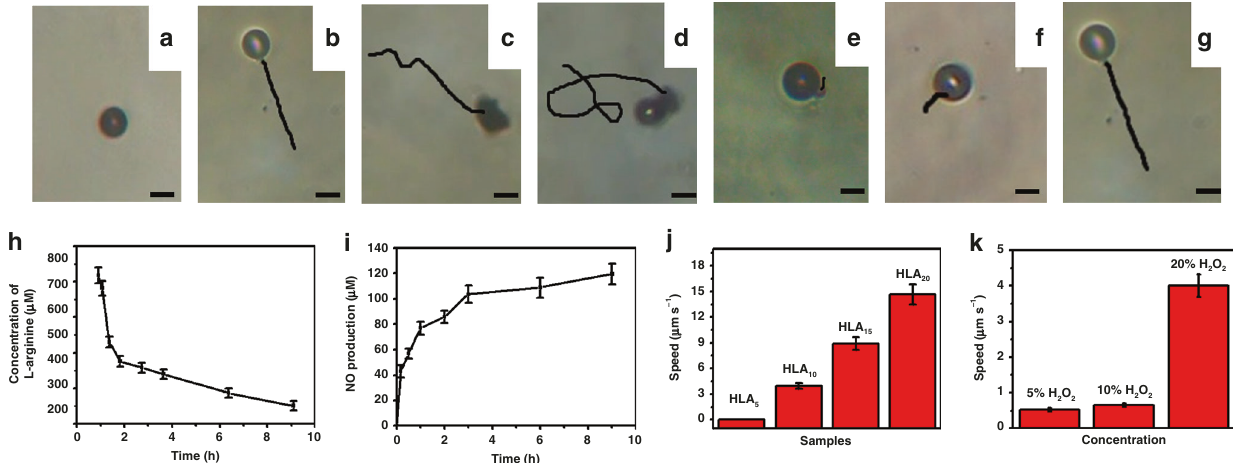
Fig. 3 Movement behavior of the nanomotors. Time-lapse images (Supplementary Movie 2) displaying the tracking trajectories of a HLA 5 , b HLA 10 , c HLA 15 , and d HLA 20 nanomotor in 10 s (20% H 2 O 2 , scale bar: 5 μ m); Time-lapse images (Supplementary Movie 3) displaying the tracking trajectories of HLA 10 nanomotor in 10 s under e 5%, f 10%, and g 20% of H 2 O 2 (Scale bar: 5 μ m); h The consumption of L -arginine and i production of NO during motion process for HLA 10 nanomotor (20% H 2 O 2 ); The speeds of j HLA n nanomotor in 20% H 2 O 2 and k HLA 10 nanomotor in different H 2 O 2 concentrations. Experimental data are mean + / − s.d. of samples in a representative experiment ( n =